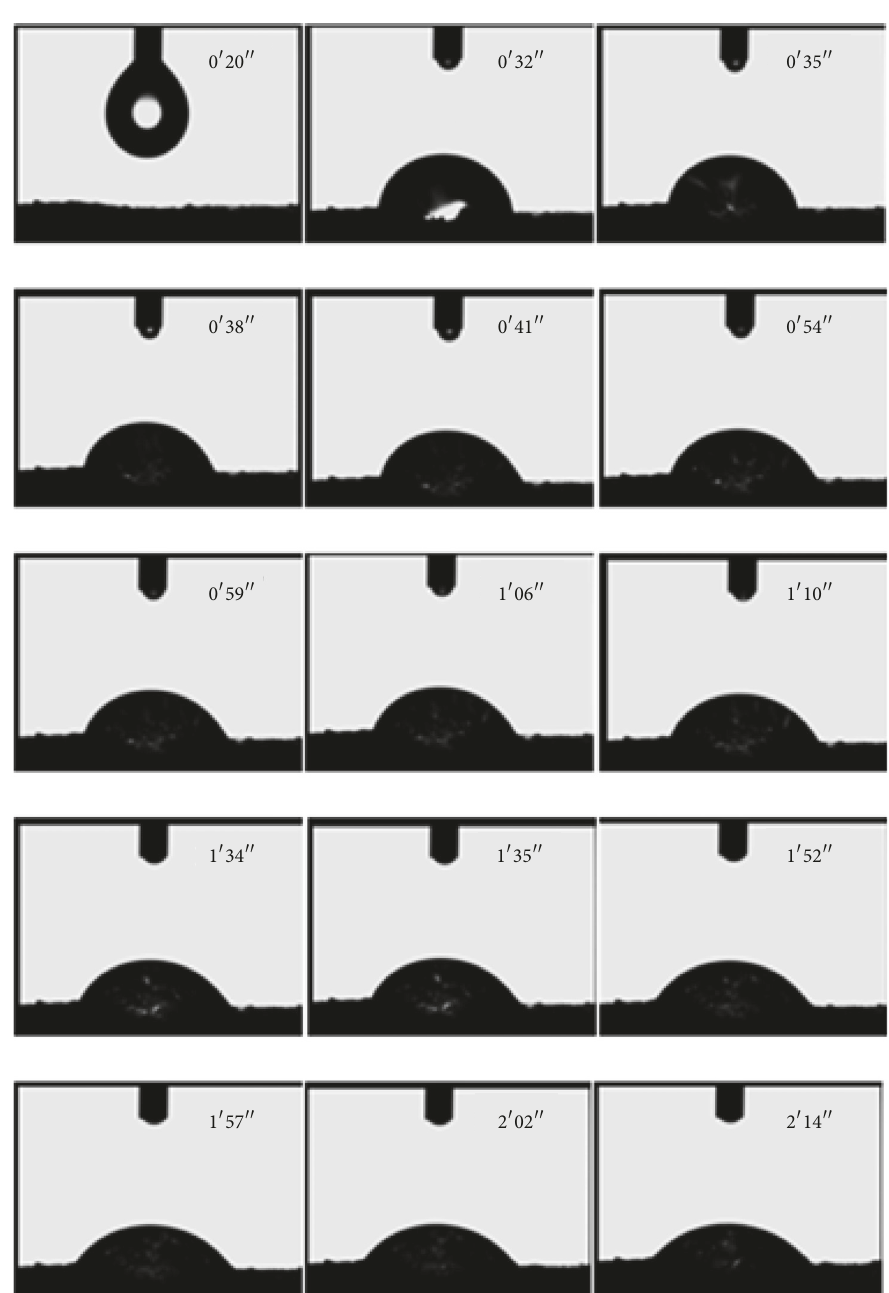
Figure 4: Contact angle images took at different times for the chitosan membrane, CB0. Total time: 2 minutes and 20